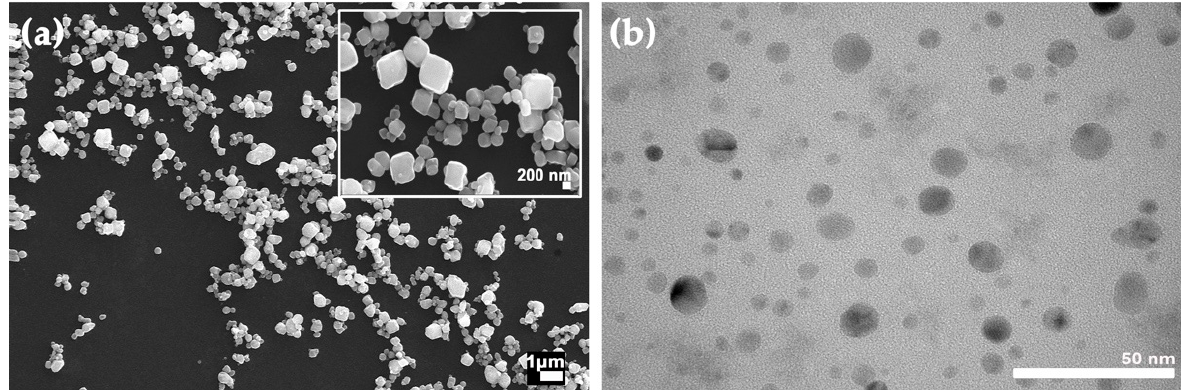
Figure 1. ( a ) FE-SEM images of Cu-CPs and ( b ) TEM images of Cu-NPs.